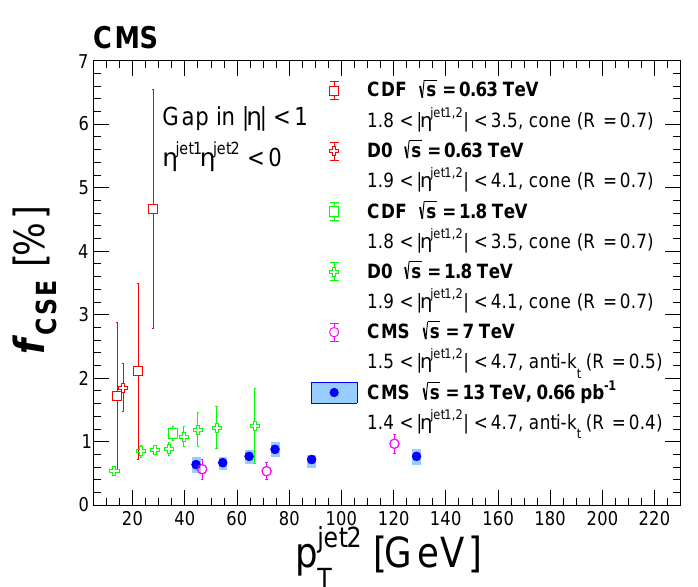
Figure 3: Fraction of color-singlet exchange dijet events, f , measured as a func- CSE (cid:112) s = 0.63 (red open symbols) and 1.8 TeV (green tion of p jet2 by D0 and CDF at T open symbols), by CMS at 7 TeV (magenta open symbols), and the present results at 13 TeV (filled circles). The vertical bars of the open symbols represent the total experimental uncertainties. The vertical bars of the 13 TeV measurement represent the statistical uncertainties, and boxes represent the combination of statistical and systematic uncertainties in quadrature. The jet p and η requirements of the pre- T vious measurements are specified in the legend of the plot. The figure is extracted from Ref. [ 1 ] .